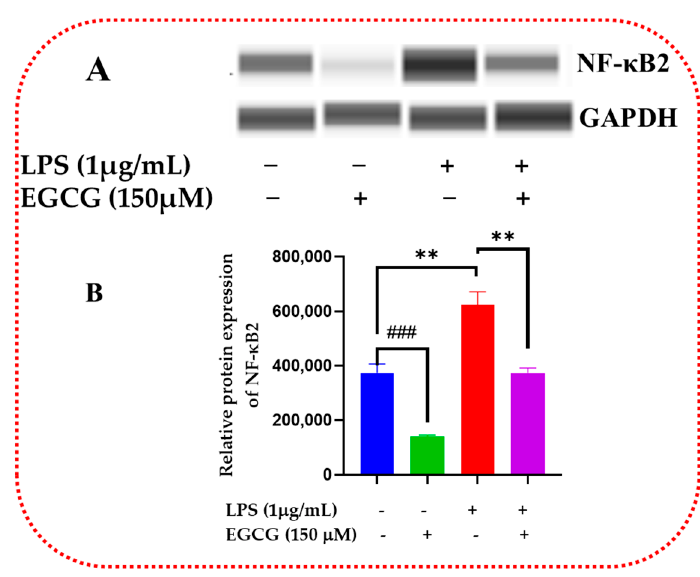
Figure 15. EGCG downregulated relative protein expression of NF- κ B2. Western blot representative image of NF- κ B2 evaluation demonstrated that EGCG 150 µM coupled with LPS 1 µg/mL displayed in bands in ( A ) and the graph in ( B ), reduced protein expression of the analyte as mentioned above compared to LPS. EGCG 150 µM alone reduced NF- κ B2 protein expression. GAPDH was used as a loading control. Values represent the mean ± SD, ** p ≤ 0.01, vs. LPS, ### p <0.001 vs. control.